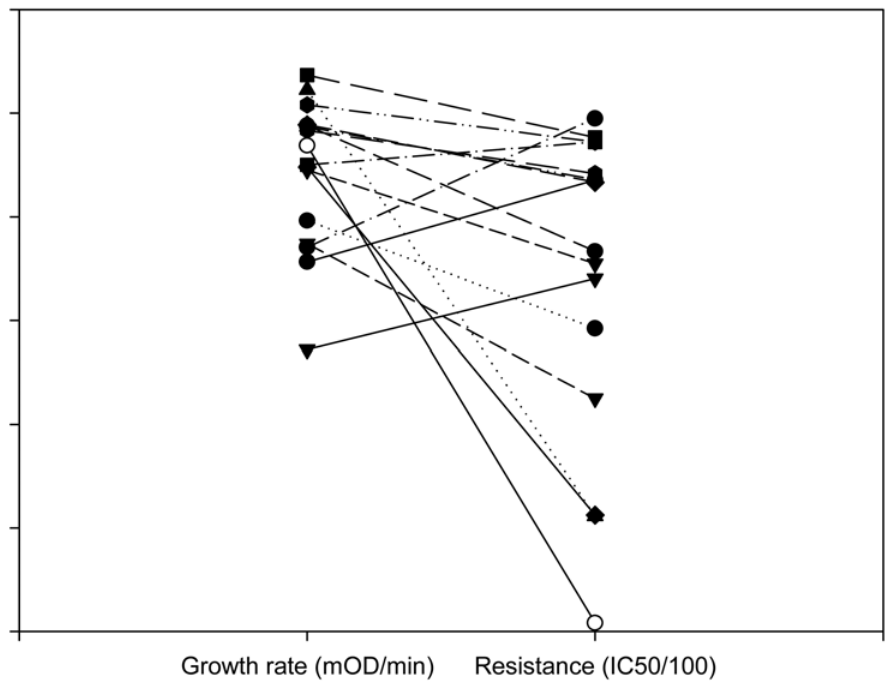
Figure 4. Phenotypic traits under selection. Plotted points show the rifampicin resistance and growth rate in media lacking rifampicin of beneficial mutation (filled symbols) and the wildtype (open